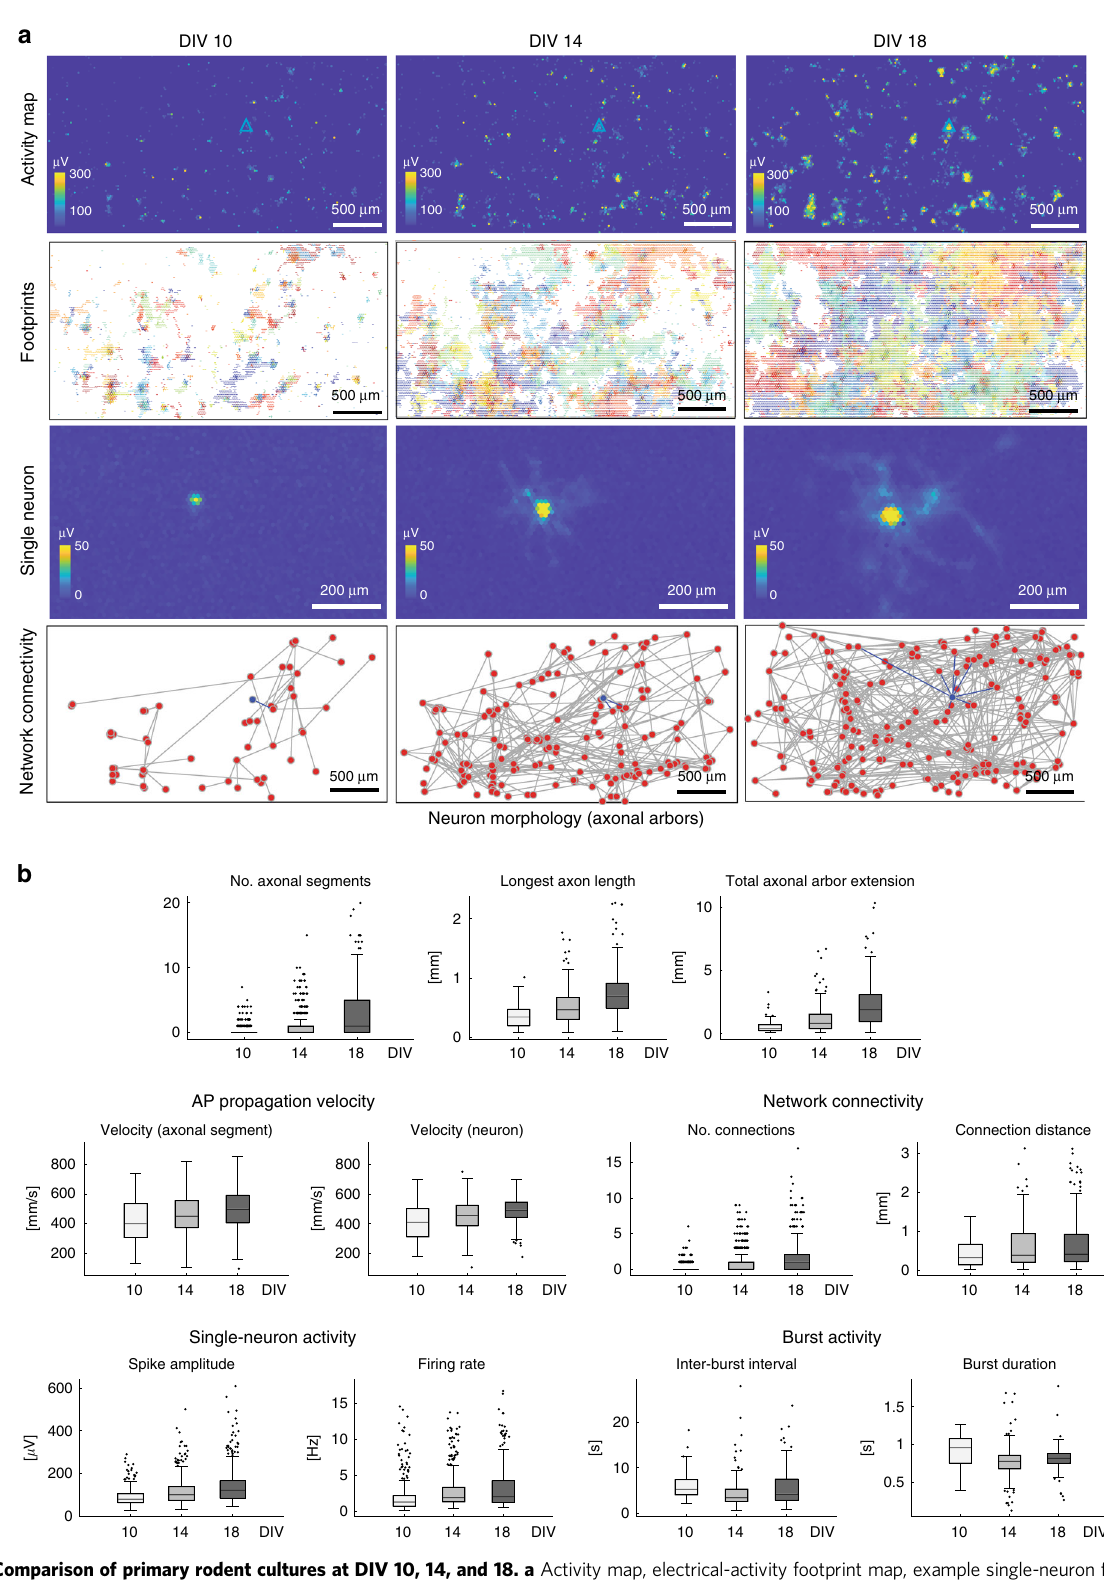
Fig. 7 Comparison of primary rodent cultures at DIV 10, 14, and 18. a Activity map, electrical-activity footprint map, example single-neuron footprint, and network-connectivity map of one selected culture at the different development stages (204 neurons). The location of the selected neuron has been marked in blue in the amplitude map, and the network connectivity of a selected single neuron has been indicated with blue lines in the connectivity map. b The statistics at the different DIVs are summarized ( n = 3 cultures, 538 neurons), including activity-related features (spike amplitude and fi ring rate), single-cell related features (the number of axonal segments, total extension of axonal arbors, longest axon length and AP propagation velocity for all neurons), and network- related features (interburst interval, burst duration, number of connections per neuron, and the connection Euclidean distance). The box plots display the 25th percentile, median, and 75th percentile, and the whiskers represent ±1.5× interquartile range. Source data are provided as a Source Data fi